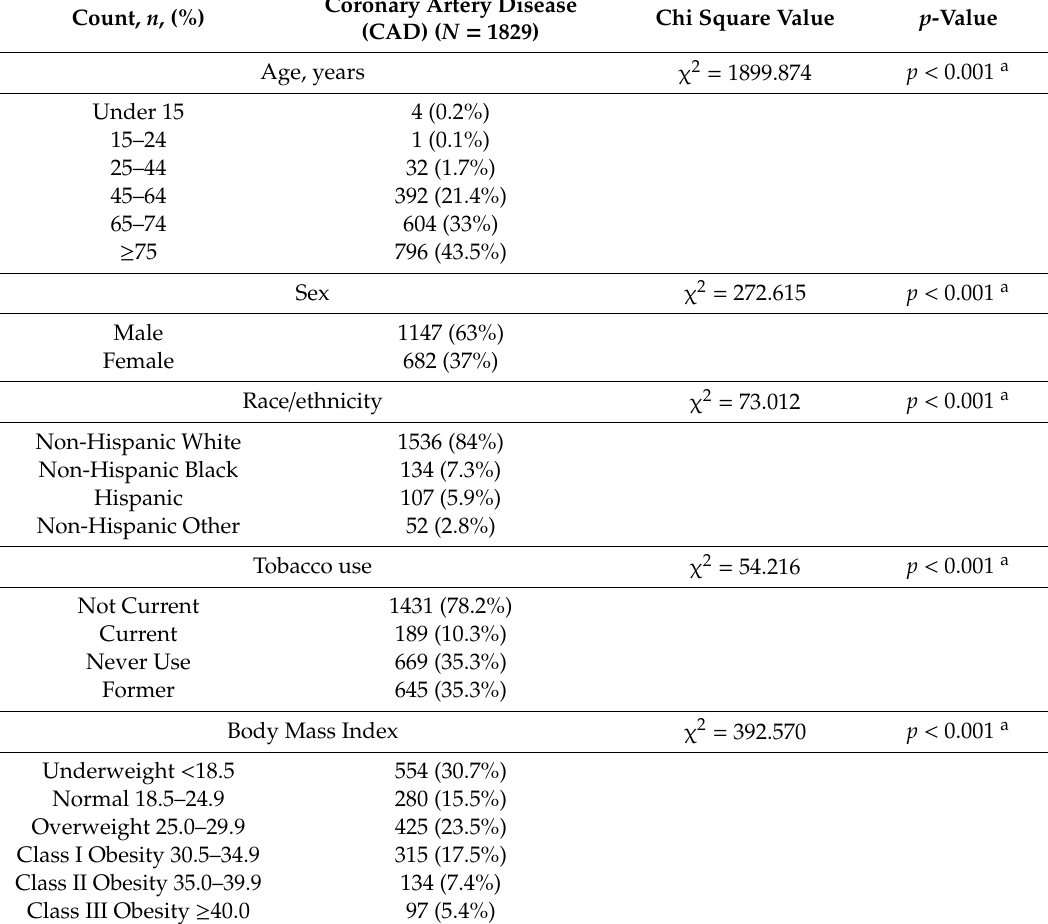
Table 1. Characteristics of the sample